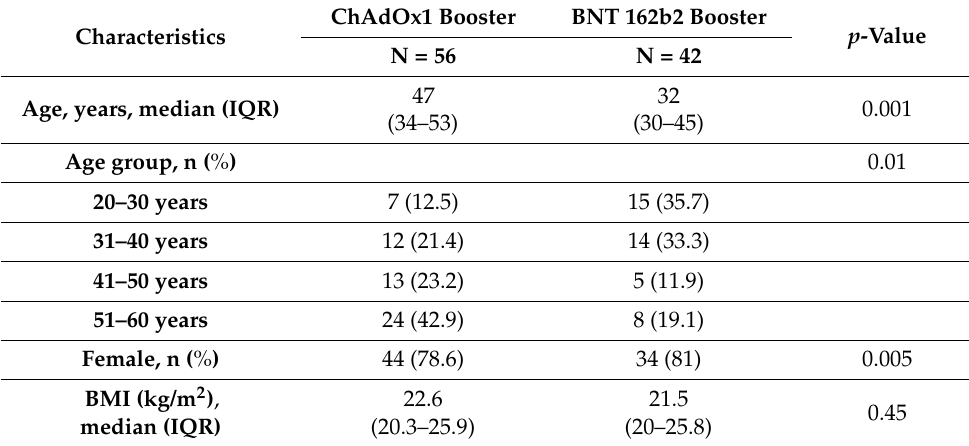
Table 1. Baseline characteristics of the participants who received primary immunization with Coron- aVac and booster with ChAdOx1 or BNT162b2.